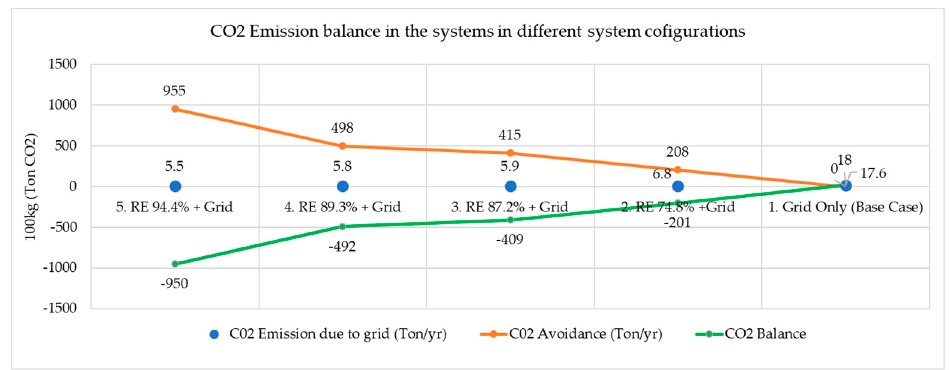
Figure 13. CO 2 emission balance in the systems. The balance was calculated considering grid emission factor of Bangladesh, which is 670 g/kWh.